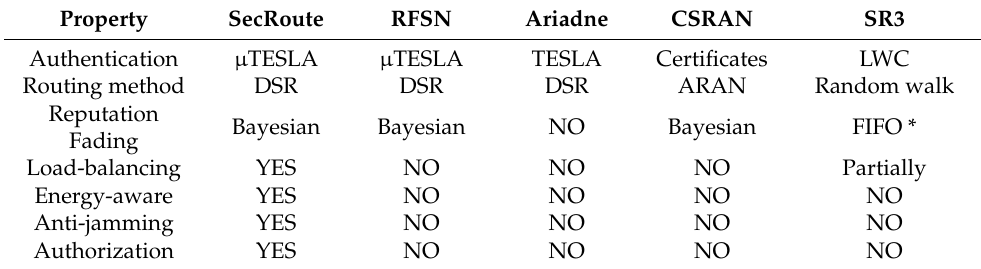
Table 4. Secure routing protocols.